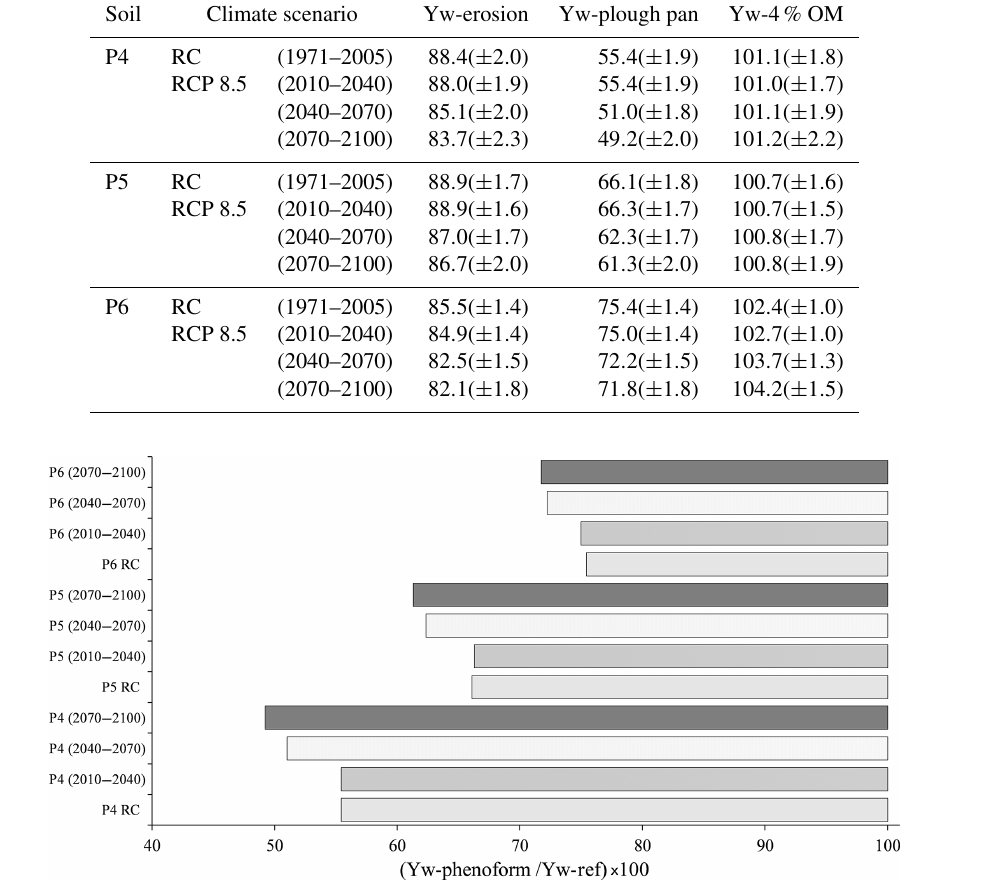
Figure 2. Range of soil health indexes – SH = (Yw-phenoform/Yw-ref) × 100 – for the three soils, demonstrating differences among soils and projected effects of climate change. This range characterises the inherent soil quality (SQp) for these particular soil